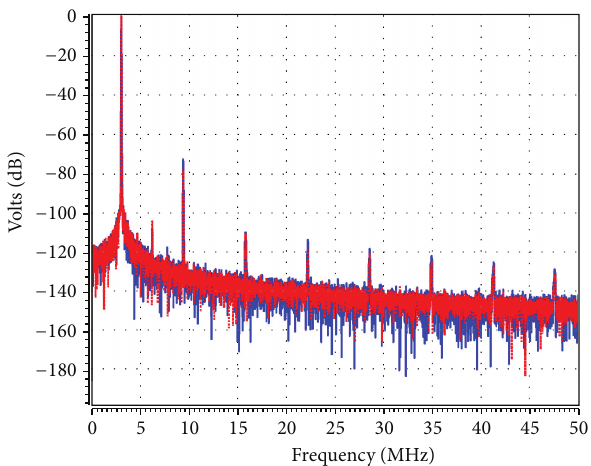
Figure 12: Oscillation frequency against the bias current 𝐼 𝐵4 of the circuit (o, simulated frequency, theoretical curves).